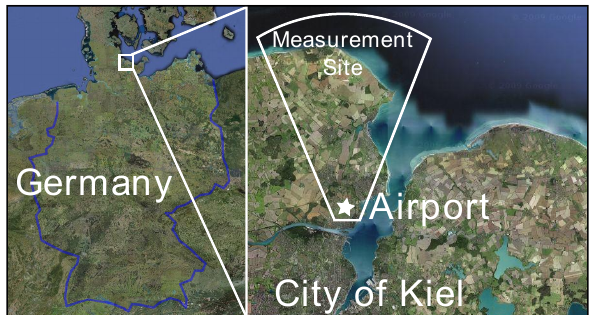
Fig. 1. Measurement site at the airport of Kiel-Holtenau (maps are taken from